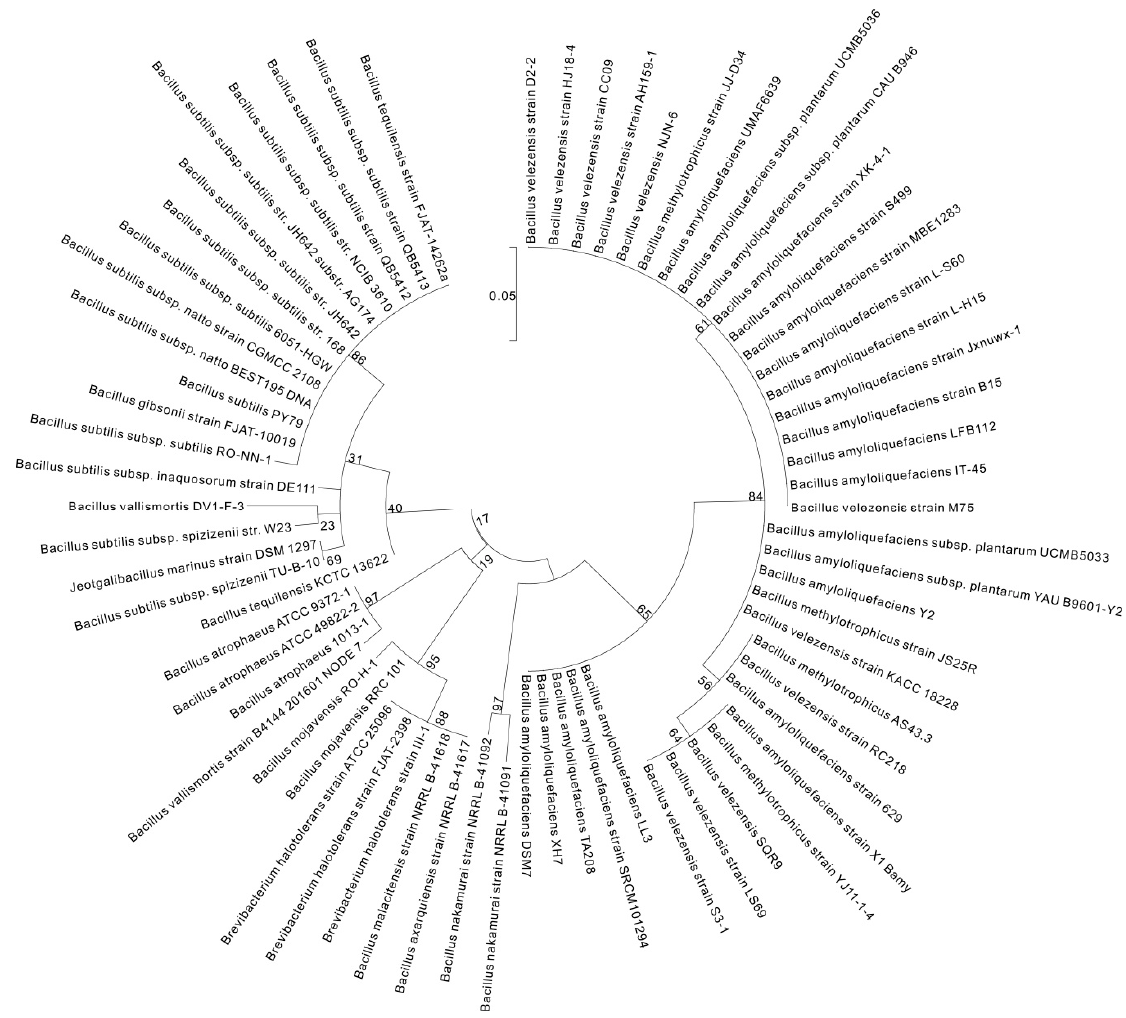
Figure 6. Molecular phylogenetic analysis of pgsE by the maximum likelihood method. The phylogenetic tree with branch lengths was measured as the number of substitutions per site. The analysis involved 192 nucleotide sequences. Partial deletion was used and all positions with less than 95% site coverage were eliminated, i.e., less than 5% of the alignment gaps, instances of missing data, and ambiguous bases were allowed at any position. Scale bar: number of substitutions per site. Evolutionary analyses were conducted in MEGA7 [38].